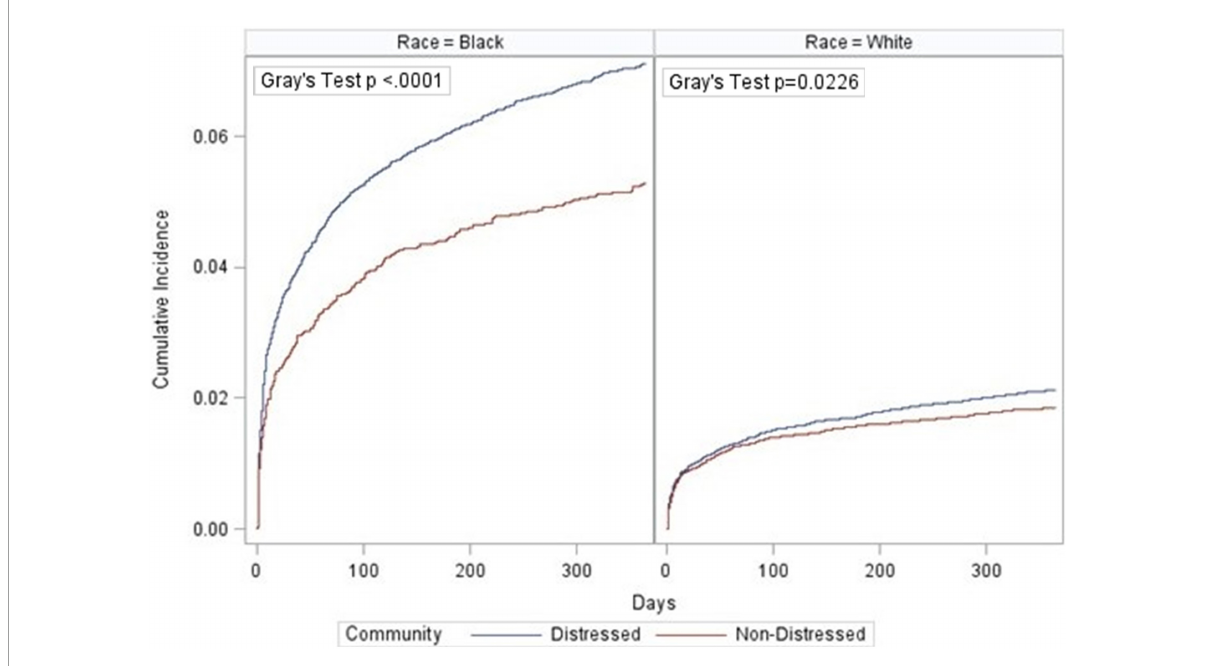
FIGURE2 Cumulative incidence function of amputations by community distress level and race.